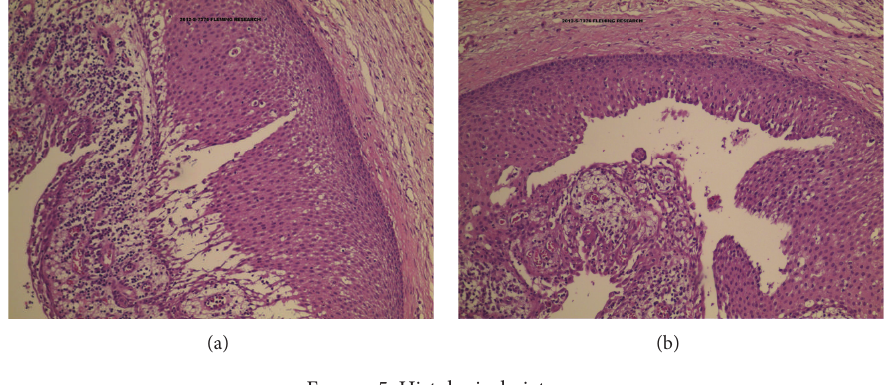
Figure 5: Histological pictures.